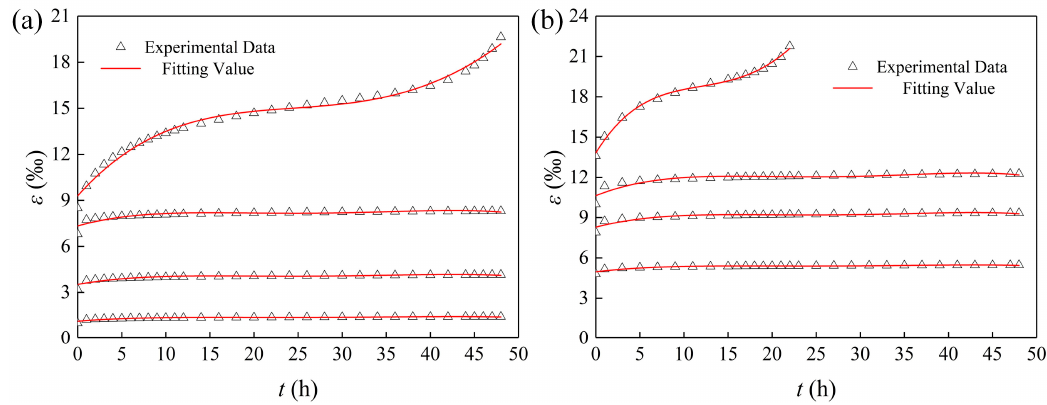
Figure 10. Comparison between experimental data and fitting values under different confining pressures: ( a ) 3 MPa, ( b ) 12 MPa.